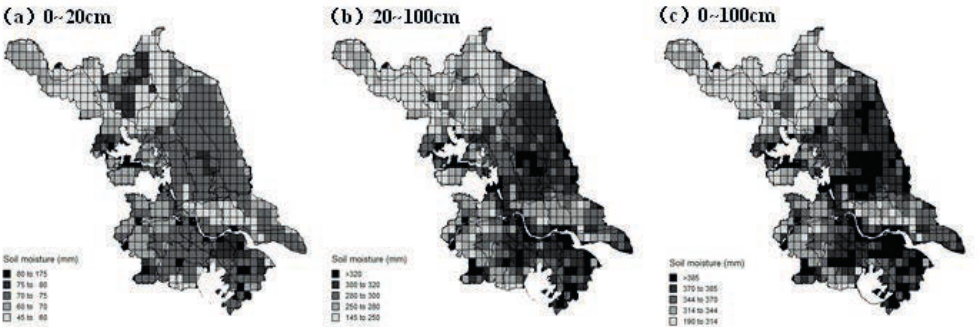
Fig. 4 Spatial distributions of simulated soil moisture of Jiangsu province.